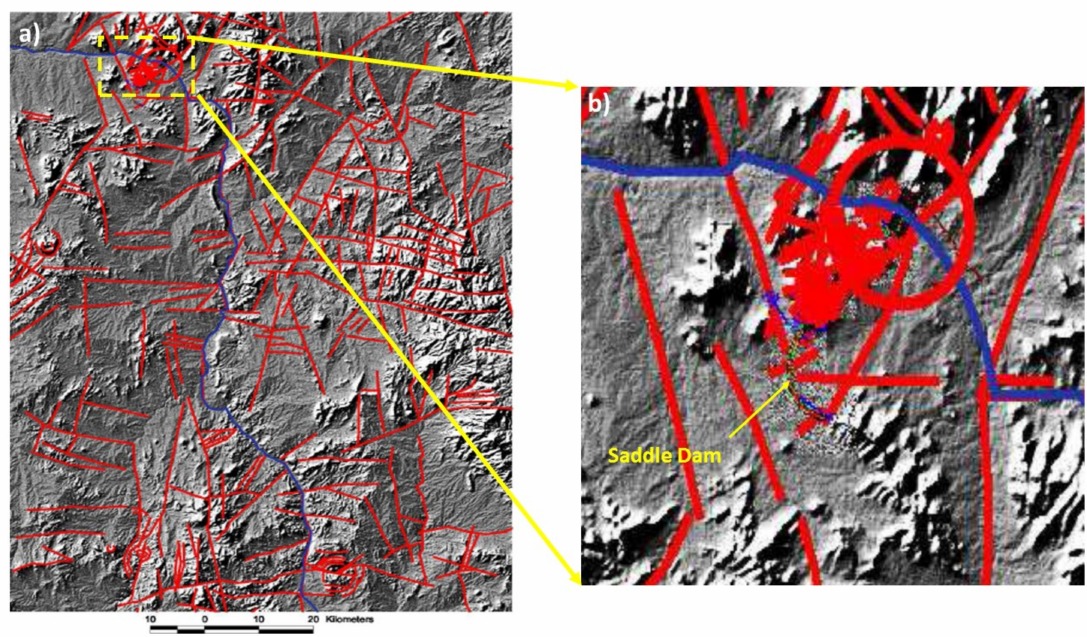
Figure 8. Tectonic elements for the Blue Nile Valley showing ( a ) the structural map as obtained from the Hillshade onstained from Shuttle DTM ( b ) zoom in shot over the Saddle Dam region and all weak